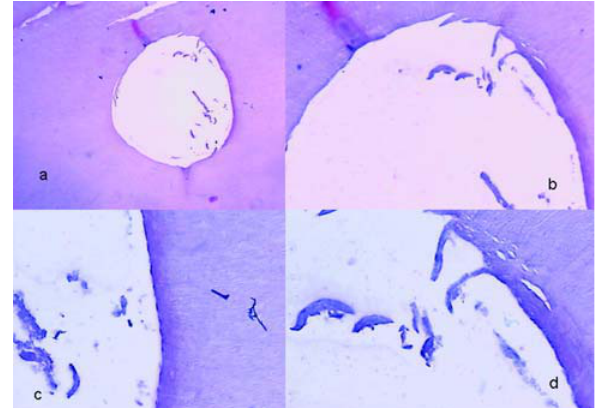
FIGURE 6- Group VI- F3 instrument associated with distilled water irrigation (HE, a-40x; b-100x; c and